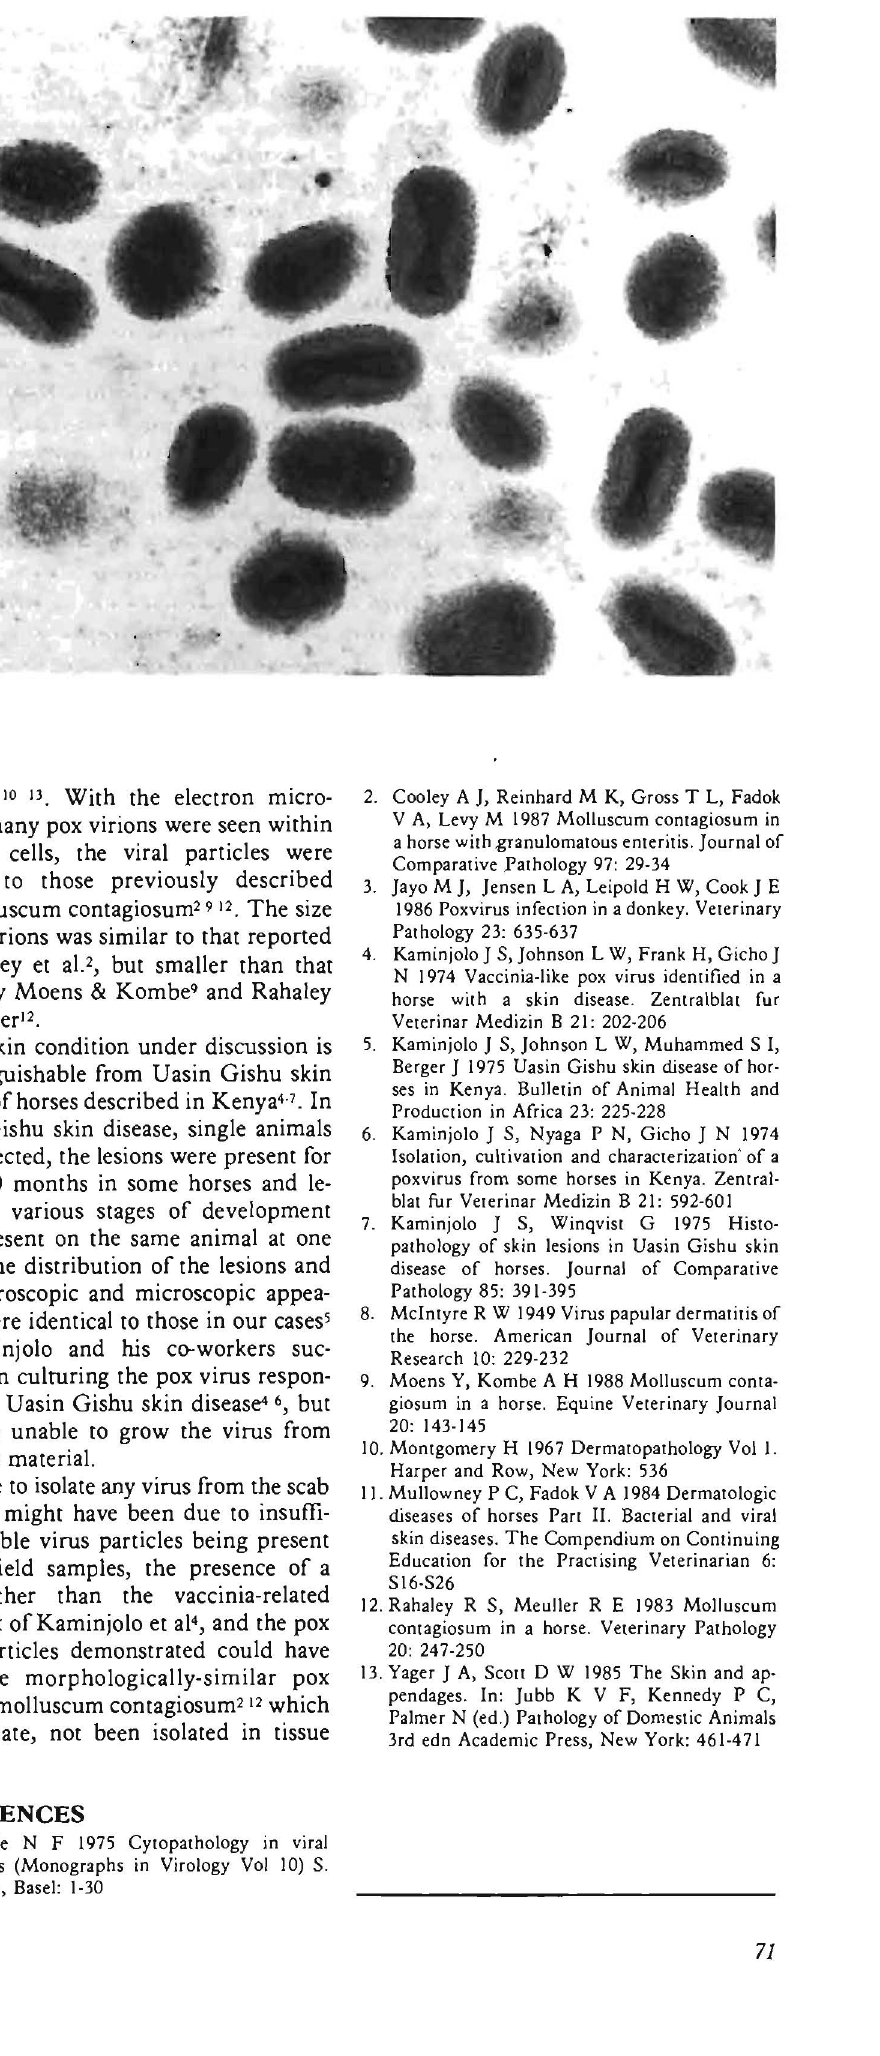
fig. 6: Typical pox virus particles in the cytoplasm of a stratum spinosum cell. X